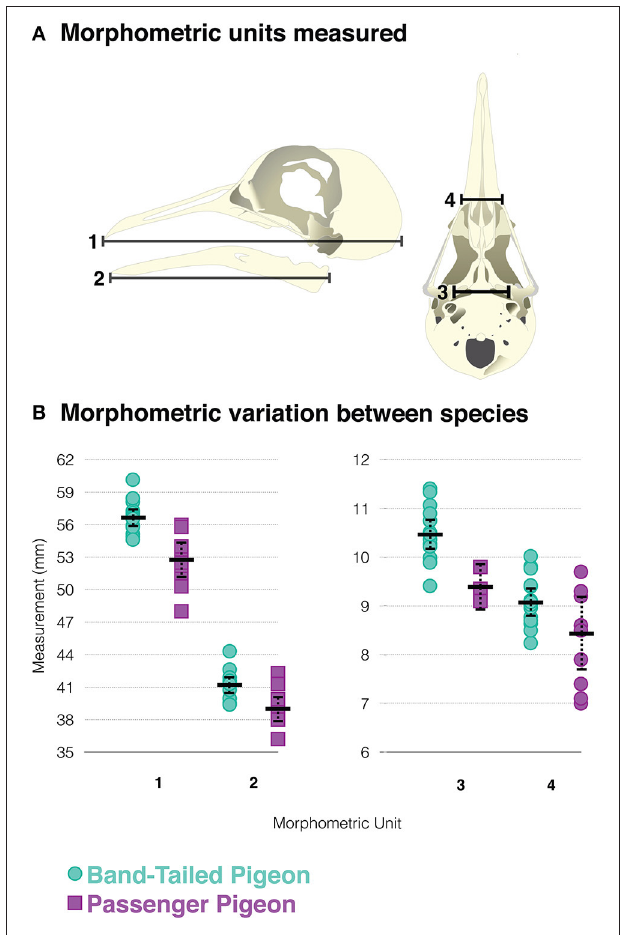
FIGURE 1 | (A) Diagram of dry skull morphometric measurements used to compare passenger pigeons and band-tailed pigeons. (B) Comparison of passenger pigeon and band-tailed pigeon morphometric variation. Black bar = mean, dotted-lines delineate 95% confidence interval.